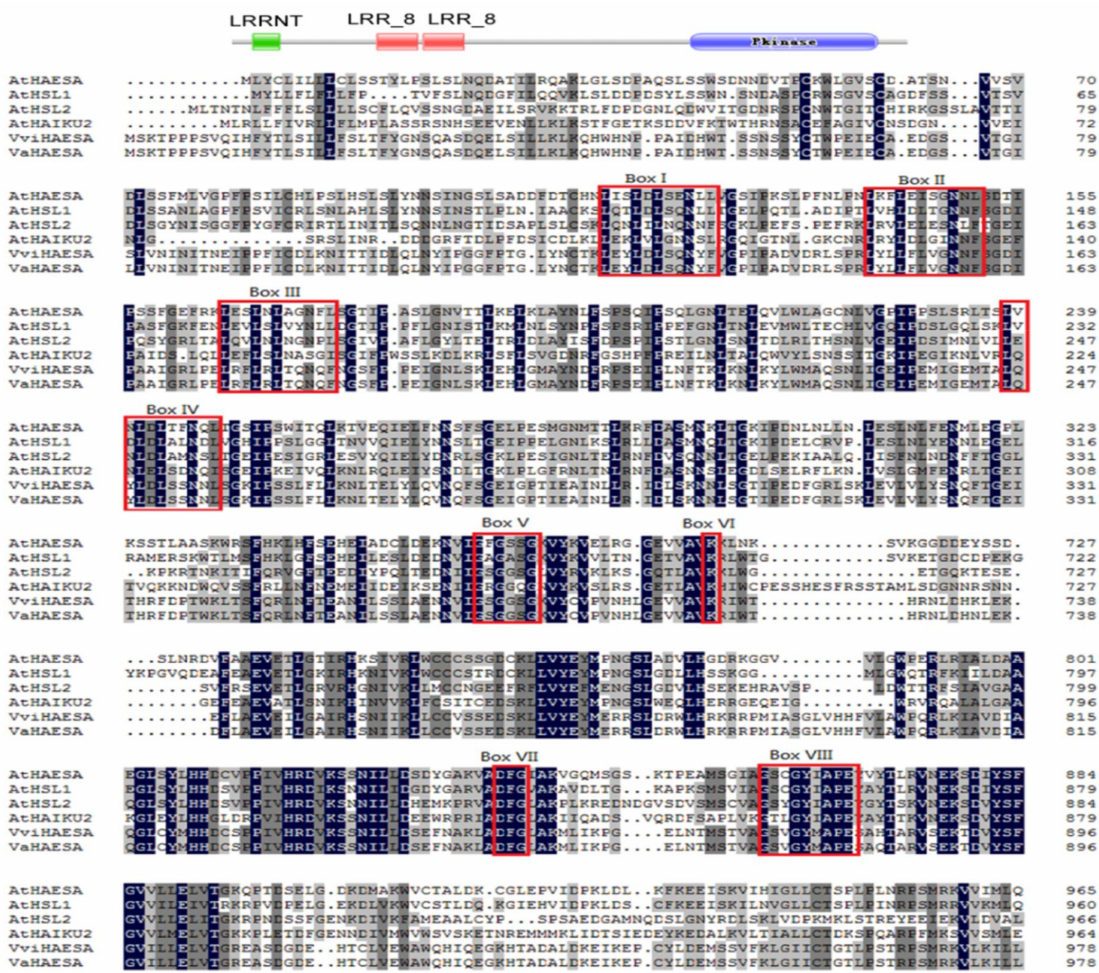
Figure 3. Alignment of the putative Vitis amurensis HAESA ( VaHAESA ) protein sequence with other HAESA and HAESA-like proteins. Box I–IV: leucine-rich repeat (LRR) core LXXLXLXXNXL motifs; Box V–VII: motifs involved in the kinase catalytic